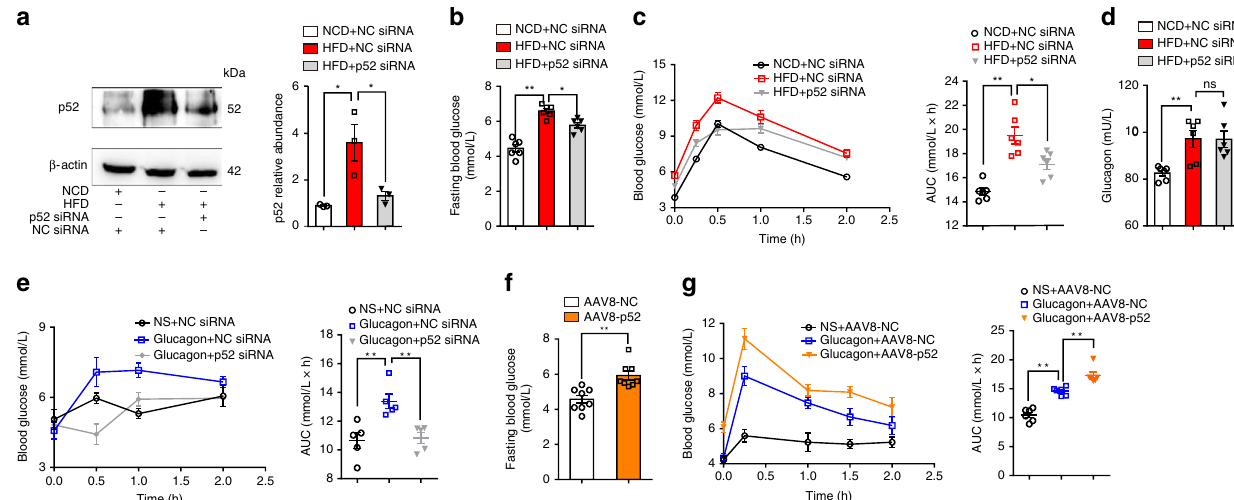
Fig. 1 Treatment with p52 siRNA reduces fasting hyperglycemia in HFD-fed mice. a p52 protein level in liver tissue of NCD-fed, HFD-fed, and HFD-fed mice treated with p52 siRNA or NC siRNA. Liver tissues were collected from the mice after 8 weeks feeding ( n = 3). b Fasting blood glucose in mice in panel a after 7 weeks feeding ( n = 6). c Pyruvate tolerance test (2 g/kg body weight) in the mice in panel a after 7 weeks of feeding. AUC is indicated on the right ( n = 6). d Fasting serum glucagon levels in mice in panel a fed with NCD or HFD for 8 weeks ( n = 6). e Blood glucose levels in normal mice subjected to glucagon challenge (2 mg/kg body weight) and treatment with p52 siRNA or NC siRNA. AUC is indicated on the right ( n = 6). f Fasting blood glucose of liver-speci fi c p52 overexpression mice ( n = 8). g Blood glucose curve and AUC for mice that are either treated with AAV8-p52 or AAV8-NC after glucagon injection ( n = 6). AAV adeno-associated virus, NCD normal chow diet, HFD high-fat diet, AUC area under the curve, NS normal saline. Bars